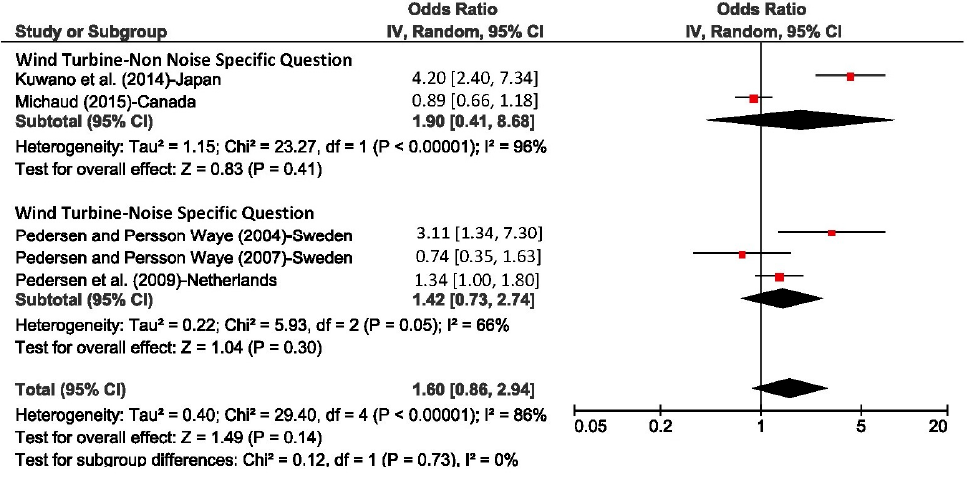
Figure 13. Meta-analysis on the effects of wind turbine noise on self-reported sleep disturbance based on Odds Ratios for a 10 dBA increase in A-weighted SPL level for wind turbine noise. The number of subjects contributing to the analyses can be found in Table 7.